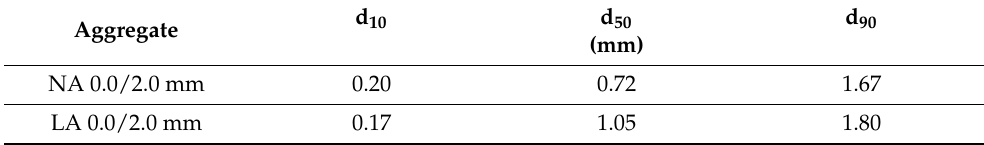
Table 4. Particle size distribution of nature aggregate (NA) and lightweight waste aggregate